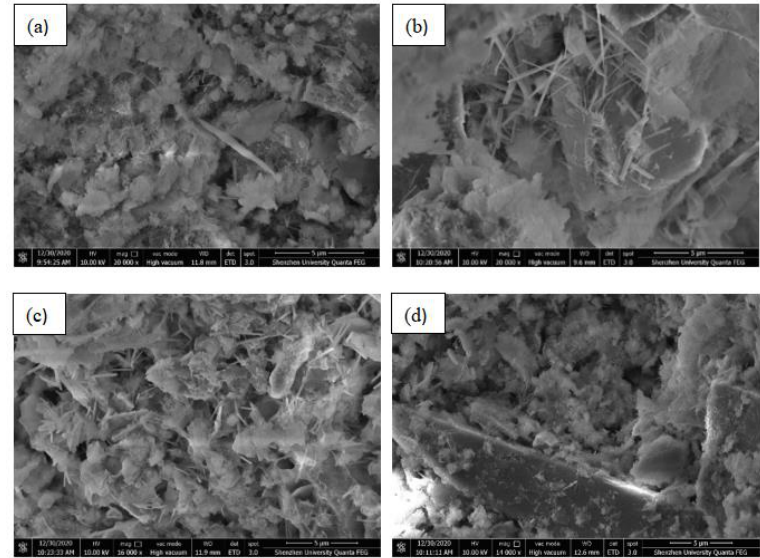
Figure 8. SEM images of samples with three binders. ( a – d ) are A3, B3, F3 and F4 after curing 28 days, respectively.